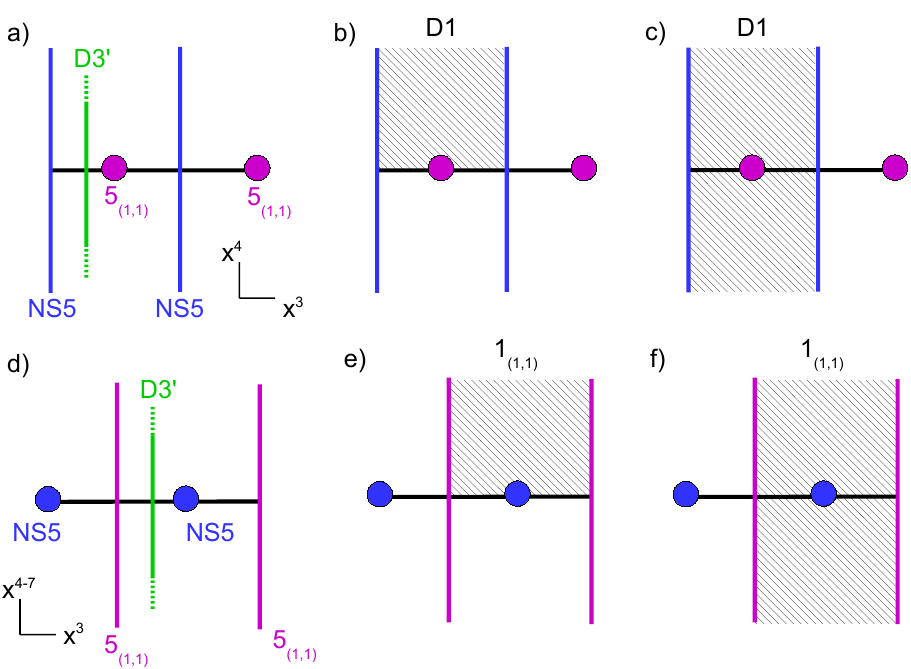
Figure 12 . Brane setups inserting chiral operators: (a) X 0 setups leading to the ring relations v +